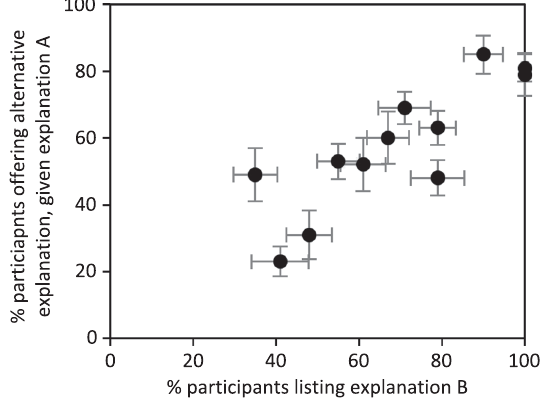
FIG. 2. Compilation of results from experiment 1, Table III (horizontal axis) and experiment 2, Table VI (vertical axis) in order to test Corollary 1. Each point represents a high or low accessibility explanation for each physical scenario. Error bars represent standard errors.